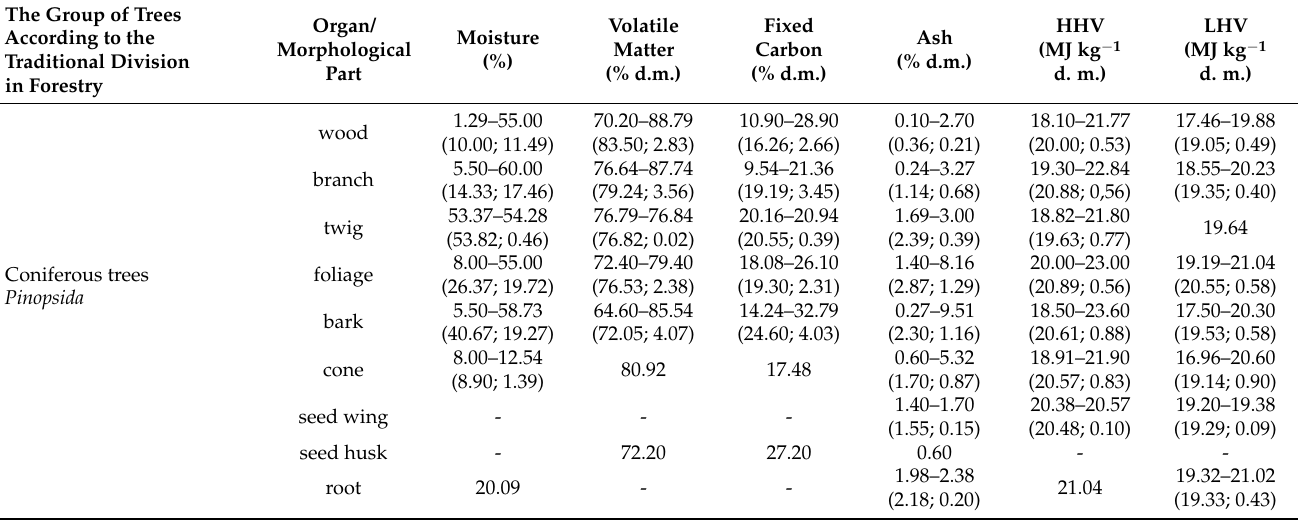
Table A4. Thermophysical properties and proximate analyses of particular organs of coniferous and deciduous